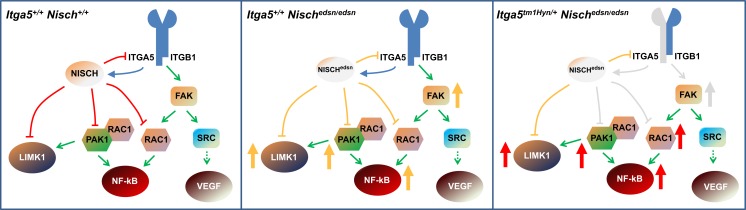
Proposed mechanism.Model of the mechanism of action in wild-type mice (Itga5+/+; Nisch+/+), during the onset OM in edison mice (Itga5+/+; Nischedsn/edsn) and in double mutants (Itga5tm1Hyn/+; Nischedsn/edsn). Nisch, Nischarin; Nischedsn, Nischarin with the edison mutation; ITGA5, integrin α5; ITGB1, integrin β1; FAK, Focal adhesion kinase; PAK1, p21-activated kinase 1; LIMK1, LIM domain kinase 1; Rac1, Ras-related C3 botulinum toxin substrate 1; NF-κB, nuclear factor kappa-light-chain-enhancer of activated B cells; SRC, Proto-oncogene tyrosine-protein kinase; VEGF, Vascular endothelial growth factor. Red capped lines represent inhibition, yellow capped lines represent reduced inhibition and grey capped lines represent low inhibition. The blue arrow indicates the role of ITGA5 in enhancing binding of NISCH to PAK1. Green arrows indicate direct activation of downstream members of the pathway and dashed green arrows indicate indirect activation. Grey arrows indicate slightly raised levels of proteins, while yellow indicates raised levels and red indicates highly raised levels.